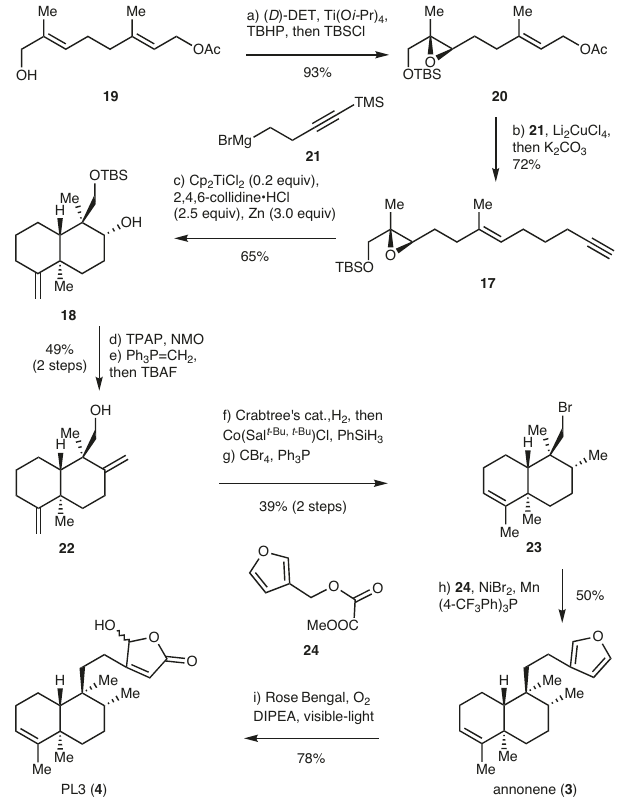
Fig. 2 | Syntheses of annonene and PL3. Reagents and conditions: a ( D )-DET (0.1 equiv), Ti(O i -Pr) 4 (0.05 equiv), TBHP (1.5 equiv, 5.5M in decane), 3Å MS, CH 2 Cl 2 , − 30°C, 12h, then TBSCl (2.0 equiv), imidazole (3.0 equiv), 0°C, 1h, 93%; b 21 (1.5 equiv), Li 2 CuCl 4 (0.1 equiv), THF, 0°C, 1h, then K 2 CO 3 (10.0 equiv), MeOH:THF= 1.5:1,23°C, 12h, 72%; c Cp 2 TiCl 2 (0.2 equiv),Zn (3.0 equiv),2,4,6-collidine·HCl (2.5 equiv), THF, 40°C, 3h, 65%; d TPAP (0.1 equiv), NMO (2.0 equiv), 4Å MS, CH 2 Cl 2 , 23°C, 1h, 82%; e NaHMDS (1.5 eqiv), Ph 3 PCH 3 Br (1.75 equiv), THF, 60°C, 8h, then TBAF (5.0 equiv), 4h, 60%; f [Ir(cod)(Py)(PCy 3 )] + PF 6 − (0.005 equiv), H 2 , CH 2 Cl 2 , 23°C,2h,thenCo(Sal t -Bu, t -Bu )Cl(0.05equiv),PhSiH 3 (0.2equiv),benzene,23°C,8h, 73%; g CBr 4 (2.0equiv),PPh 3 (3.0equiv), Py, 60°C, 4h,53%; h 24 (3.0equiv),NiBr 2 (0.3 equiv), Mn (4.0 equiv), P(4-CF 3 Ph) 3 (0.3 equiv), DMF:DMSO=1:1, 60°C, 16h, 50%; i Rose·Bengal (0.025 equiv), DIPEA (10.0 equiv), tungsten lamp (200W), CH 2 Cl 2 , − 78°C, 3h, 78%. ( D )-DET ( − )-diethyl D -tartrate, TBHP t -butyl hydroper- oxide, MS molecular seives, TBSCl t -butyldimethylsilyl chloride, THF tetra- hydrofuran,TPAPtetrapropylammoniumperruthenate,NMO4-methylmorpholine N -oxide, NaHMDS sodium bis(trimethylsilyl)amide, DMF N,N -dimethylformamide; DMSO dimethyl sulfoxide, TBAF tetrabutylammonium fl uoride, DIPEA N - ethyldiisopropylamine.